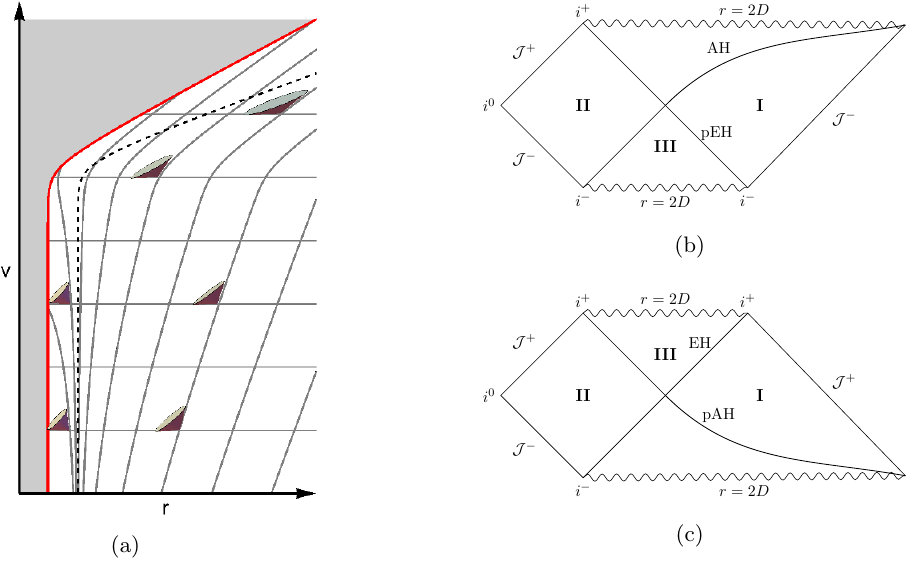
Figure 4 . Causal structure of the G(cid:127)uven-Y(cid:127)or(cid:127)uk solutions for the undercritical case, c > 1 = 2. Panel (a) shows an accreting ( (cid:15) = (cid:0) 1) spacetime diagram adopting ingoing Eddington-Finkelstein coordinates f v; r g . The thick solid (red) line represents the singularity location and the dashed (black) line indicates the future apparent horizon. Horizontal thin (grey) lines are ingoing radial null geodesics, while the remaining curved thin (grey) lines are outgoing radial light rays. The region to the left of the singularity curve is not part of the spacetime. Panel (b) displays the corresponding Carter-Penrose diagram. Panel (c) displays the time-reversal of (b). The event horizon and the apparent horizon are indicated by EH and AH, respectively, while pEH and pAH denote past event and apparent